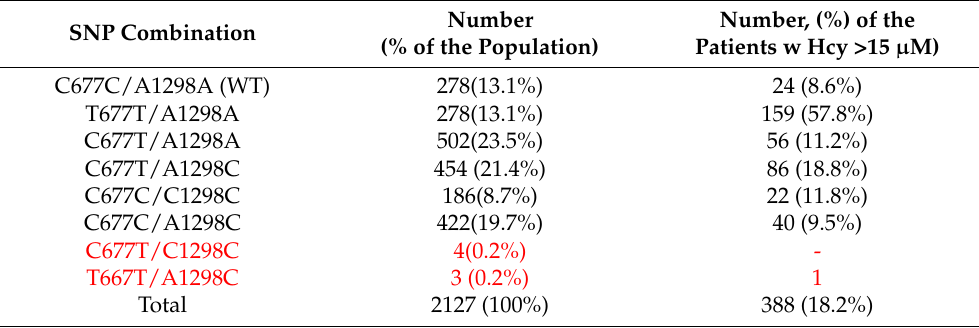
Table 1. MTHFR SNP combinations in our male hypo-fertile population (percentage of the total male population).